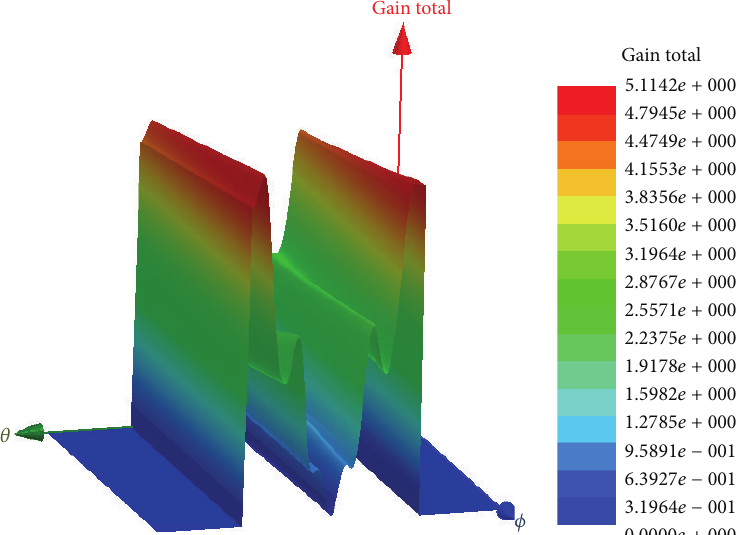
Figure 15: 3D gain of the CRA for the second iteration at 6.55 GHz.